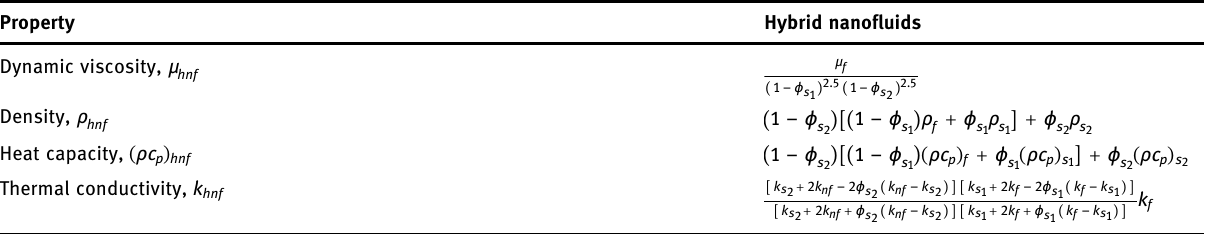
Table 3: Physical properties of hybrid nano fl uids [ 131 ]